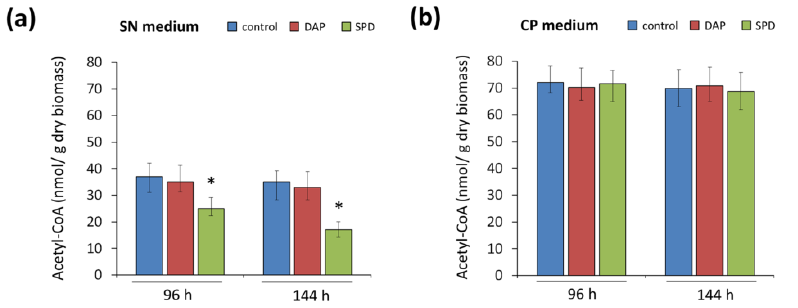
Figure 9. Effect of addition of 5 mM 1,3-diaminopropane (DAP) or 5 mM spermidine (SPD) on the cellular content of acetyl-CoA in A. chrysogenum strain HY. Cultivation on: ( a ) synthetic (SN) medium; ( b ) complex (CP) medium. Samples were taken at 96 h and 144 h. Data are means ± SD, n = 3. Statistical significance, * p ≤ 0.05, as compared with the control (strain, cultivated on medium without PAs additions).